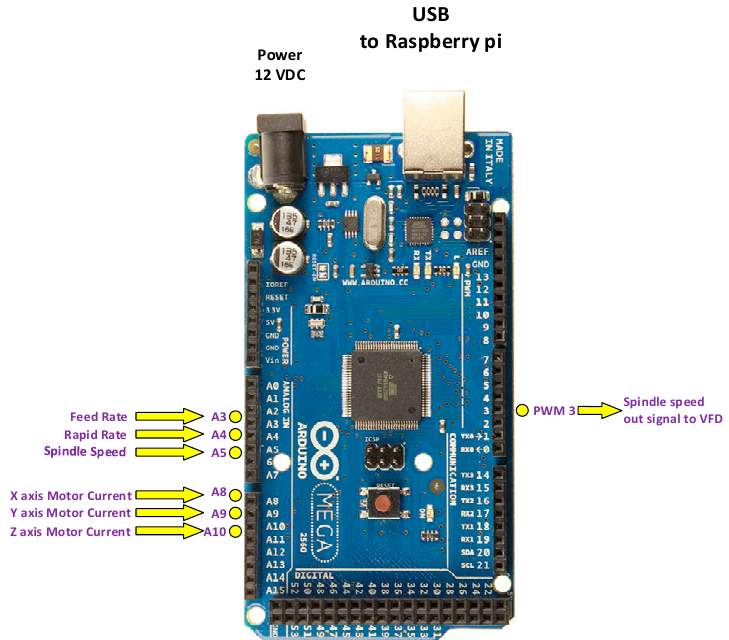
Figure 5. Arduino Mega input–output connections.